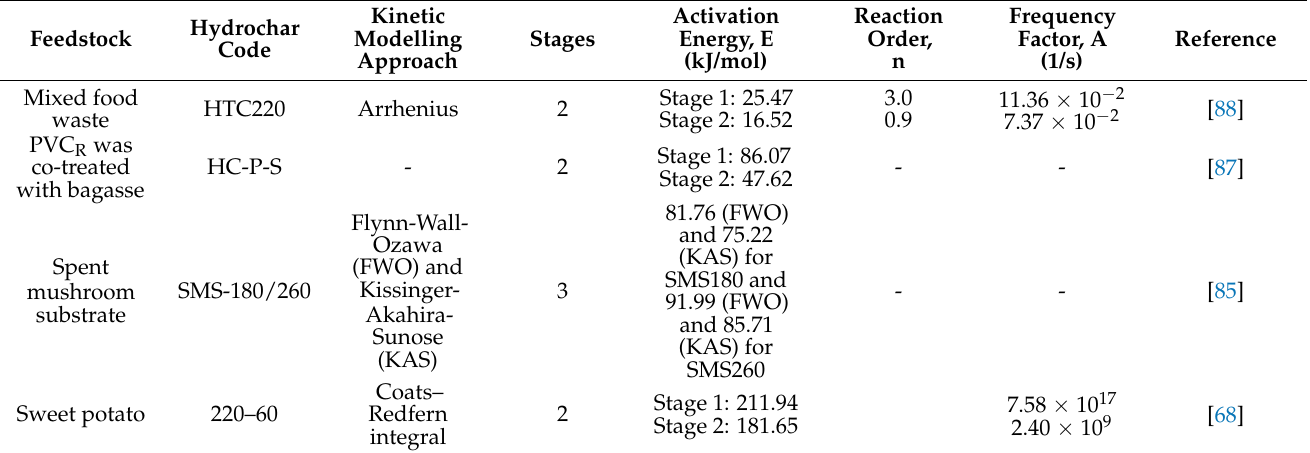
Table 5. Kinetic parameters of combustion of hydrochar from food